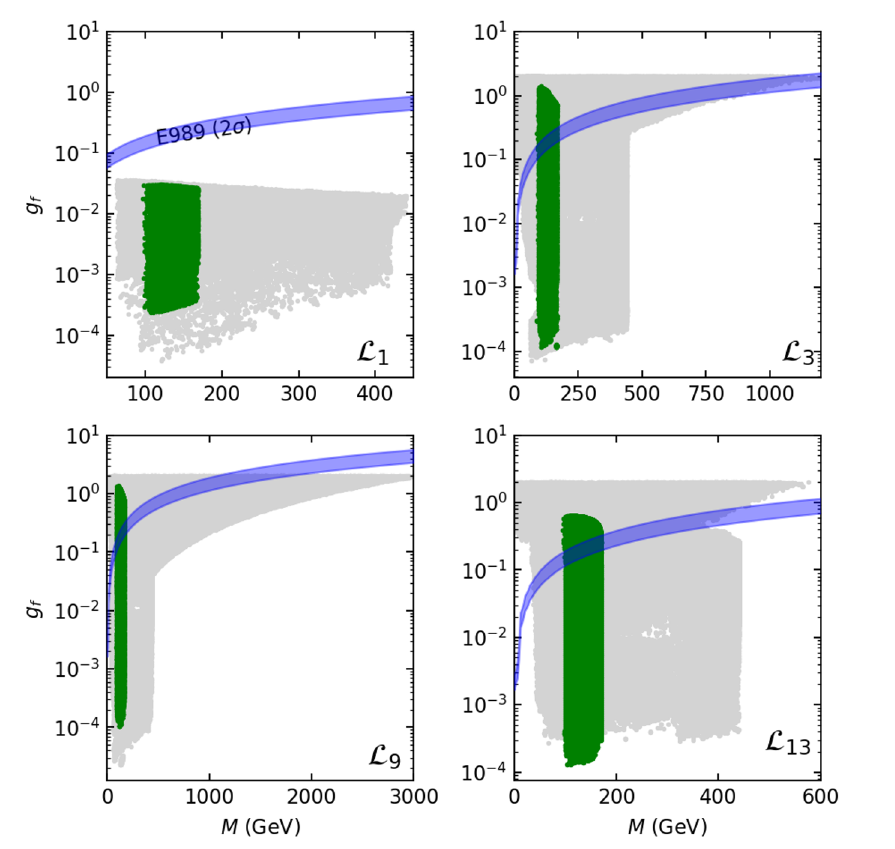
Figure 8 . The 2 σ distributions in the ( M , g f ) plane. The same color coding as figure 3 is used. The purple shaded belt corresponds to the E989 2 σ region of δa